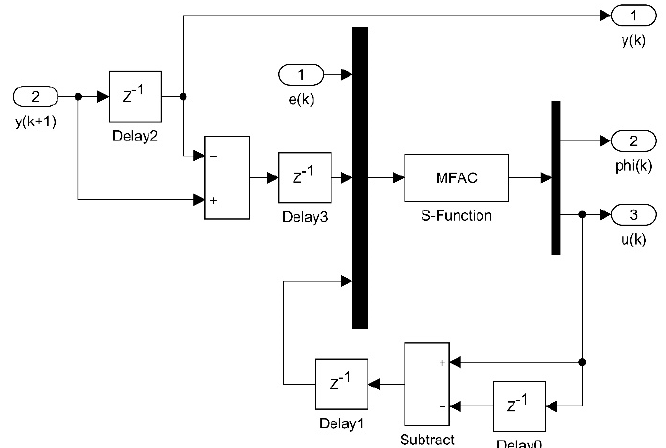
Figure 7. Kernel of MFAC Controller.